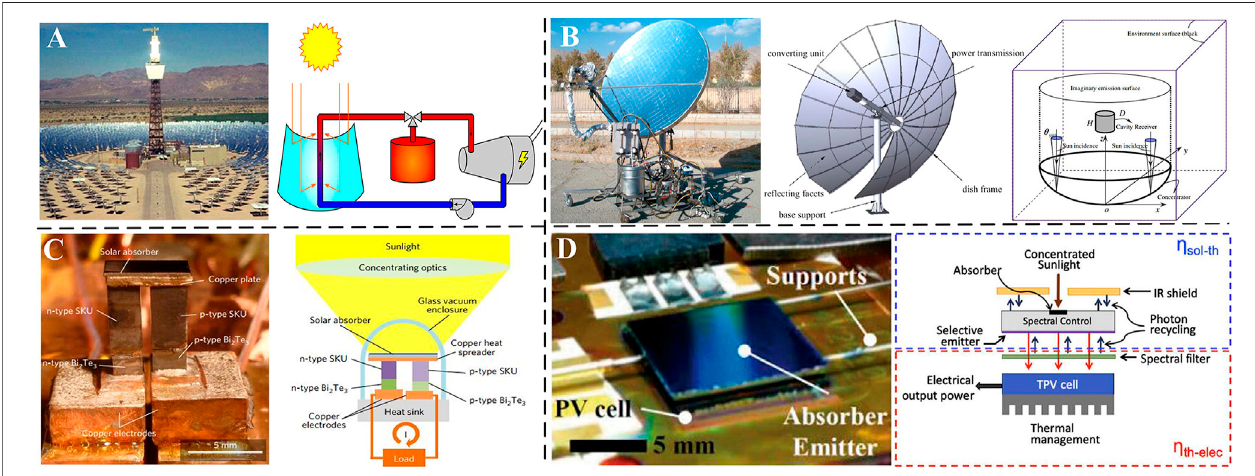
FIGURE 1 | An overview of the application of solar selective absorbing coatings (SSACs) at high temperatures. Photographs and illustrations of (A) “ Power tower ” plant (adapted from Weinstein et al., 2015). (B) Solar dishes (adapted from Mao et al., 2014; Hijazi et al., 2016; Loni et al., 2018). (C) Solar thermoelectric generators (STEGs) (adapted from Kraemer et al., 2016). (D) Solar thermophotovoltaics (STPVs) (adapted from Wang et al., 2019; Bhatt and GUPTA, 2020).